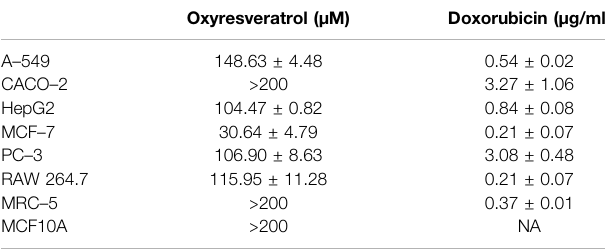
TABLE 1 | Inhibitory concentration (IC 50 , µM) of OXY to the